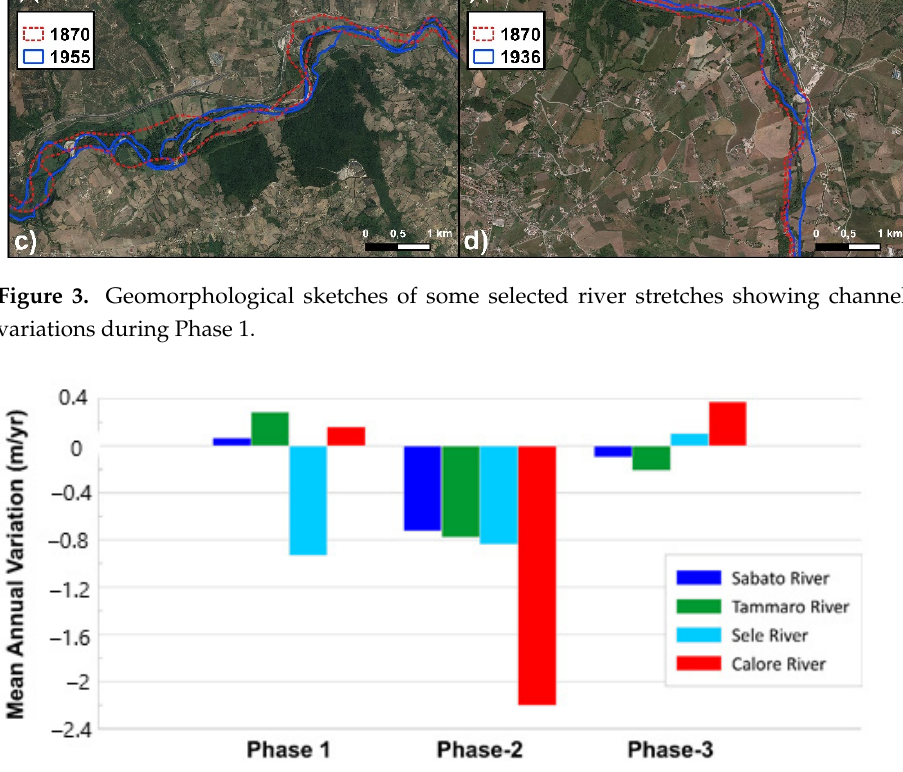
Figure 3. Geomorphological sketches of some selected river stretches showing channel width vari- ations during Phase 1.